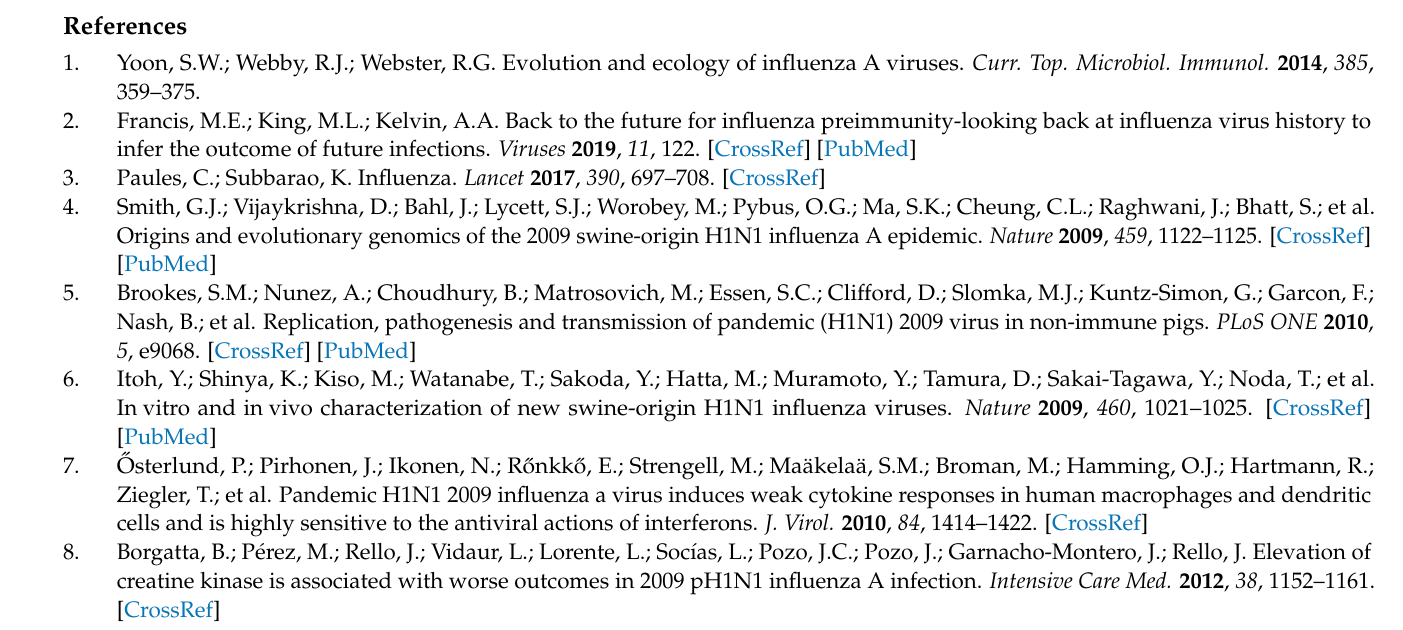
SD56. Figure S3: GO functional enrichment of differentially expressed genes in RAW264.7 cells. Figure S4: Details of the signaling pathways involved in the